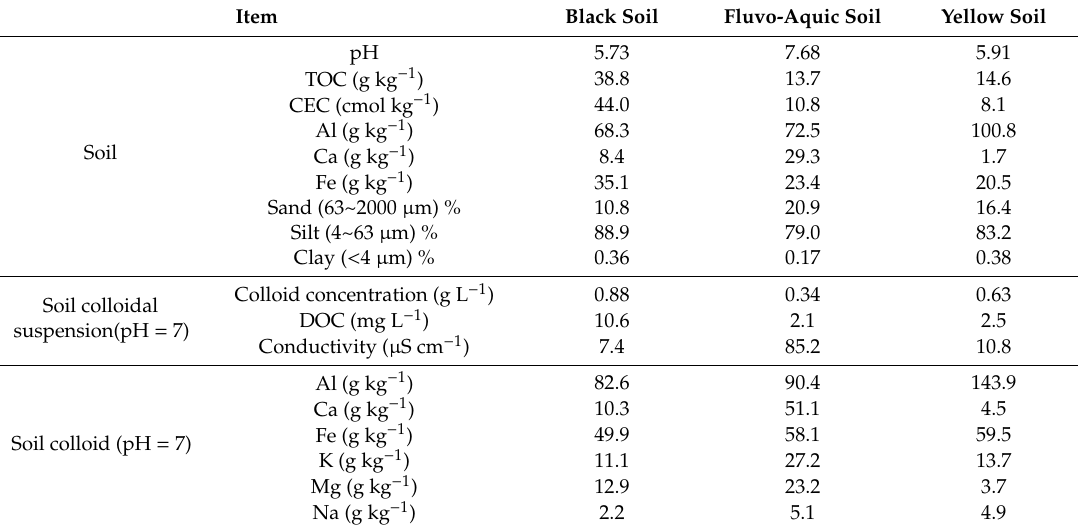
Table 2. Physicochemical properties of the soil samples and soil